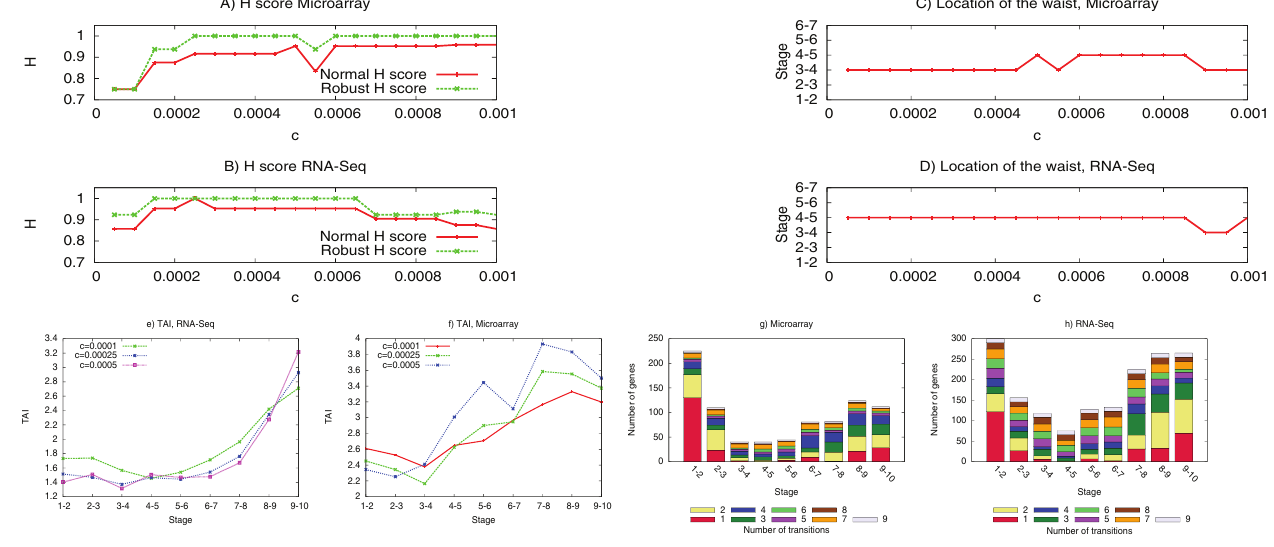
Figure 12. Drosophila results using normalized expression levels. Graphs ( A ) and ( B ) show the hourglass score (normal and robust) as a function of the transition threshold c for the two datasets. Graphs ( C ) and ( D ) show the location of the hourglass waist (stage-pair) as a function of the transition threshold c for the two datasets. Graphs ( E ) and ( F ) show the Transcriptome Age Index of transitioning genes for three different values of c (chosen so that the number of genes with known age index assigned to each stage is at least 25) for the two datasets. Graph ( G ) shows the transitioning genes for the Microarray dataset with c = 0.0005. The transitioning genes constitute 11% of all genes in that dataset. 53% of those genes transition in a single stage-pair. Of the remaining, 64% transition only in consecutive stage-pairs. Note that if a gene transitions n times, it is counted in n stage-pairs. Similarly, graph ( H ) shows the transitioning genes for the RNA-Seq dataset with c = 0.00025. The transitioning genes constitute 5% of all genes in that dataset. 45% of those genes transition in a single stage-pair. Of the remaining, 52% transition only in consecutive